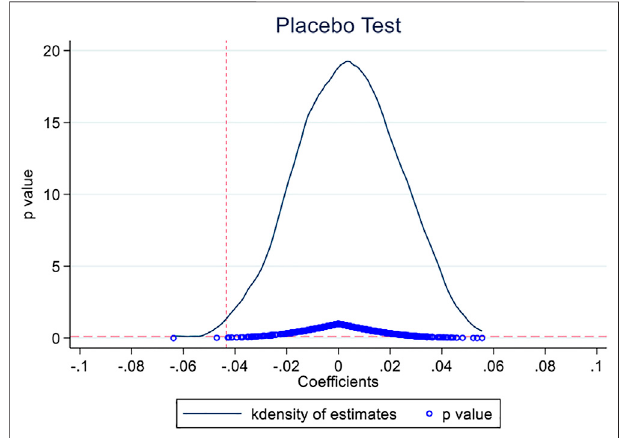
FIGURE 1 | Placebo test of randomly assigning treatment groups. Test the performance of the